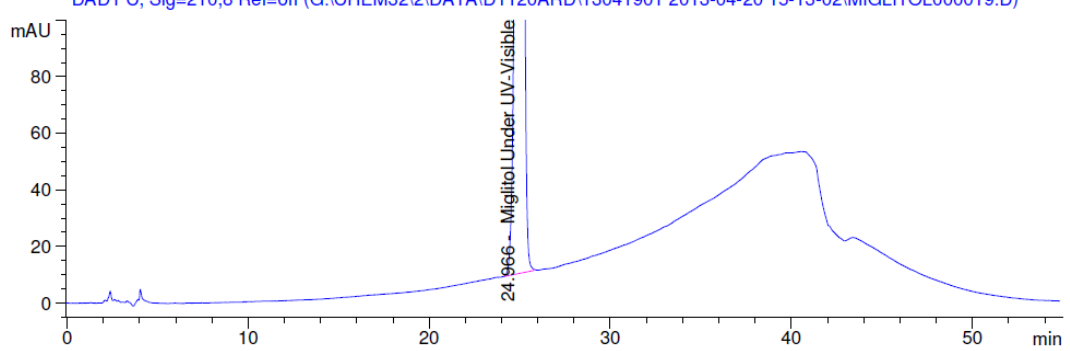
Figure 7. Chromatogram in ultraviolet (UV)-visible degradation. Sci. Pharm. 2016 , 84 , 654-page FOR PEER REVIEW